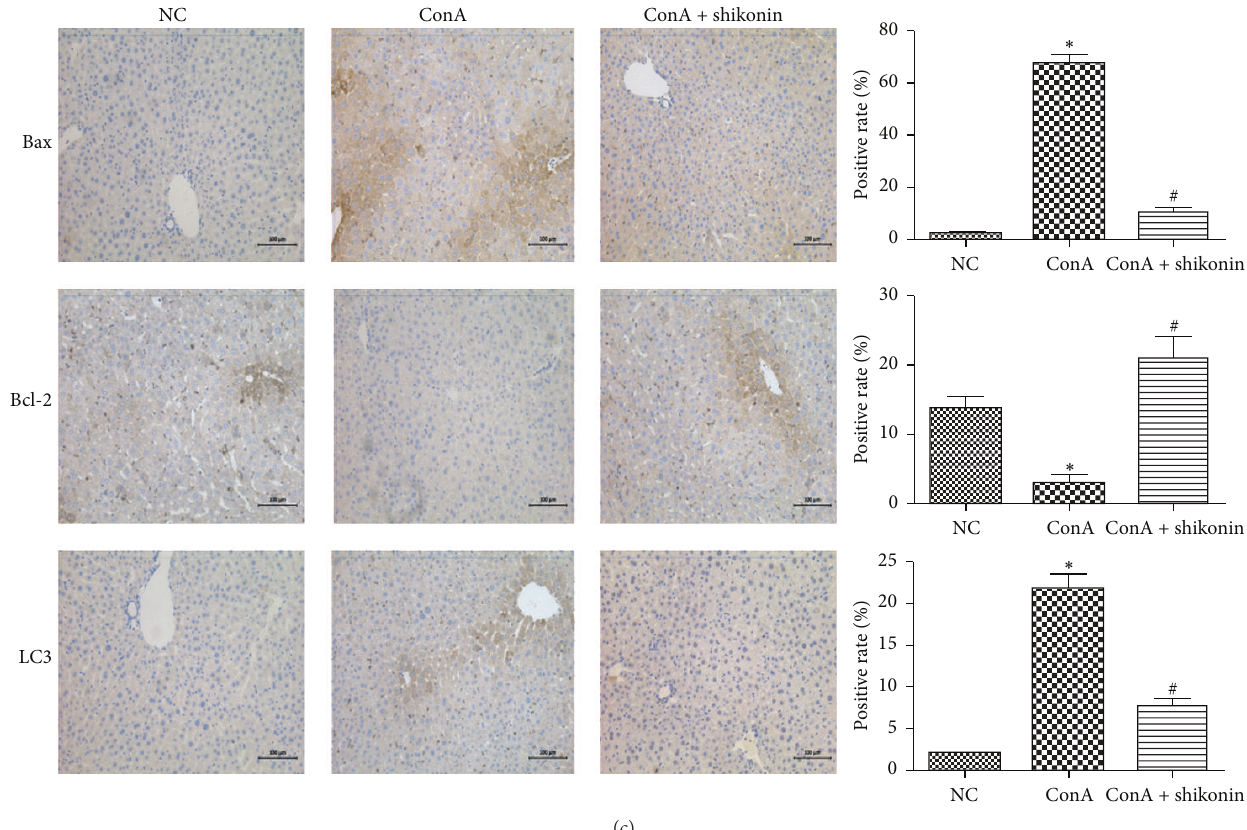
Figure 4: Effects of shikonin on apoptosis and autophagy in mice with ConA-induced acute hepatitis. (a) cDNA levels of LC3, P62, Bcl-2, and Bax were measured with real-time PCR ( 𝑛 = 8 , ∗ 𝑃 < 0.05 for NC versus ConA, # 𝑃 < 0.05 for ConA + shikonin (7.5) versus ConA, and + 𝑃 < 0.05 for ConA + shikonin (12.5) versus ConA). (b) Protein expression of LC3, Beclin-1, P62, Bcl-2, Bax, and caspase 9 was detected with western blotting and the gray values were calculated ( 𝑛 = 8 , ∗ 𝑃 < 0.05 for NC versus ConA, # 𝑃 < 0.05 for ConA + shikonin (7.5) versus ConA, and + 𝑃 < 0.05 for ConA + shikonin (12.5) versus ConA). (c) Immunohistochemistry staining ( × 200) showed the expression of Bcl-2, Bax, and LC3 protein in liver tissue at 6h. The ratio of brown area to total area was analyzed with Image-Pro Plus (v 6.0) ( 𝑛 = 8 , ∗ 𝑃 < 0.05 for NC versus ConA, # 𝑃 < 0.05 for ConA versus ConA +